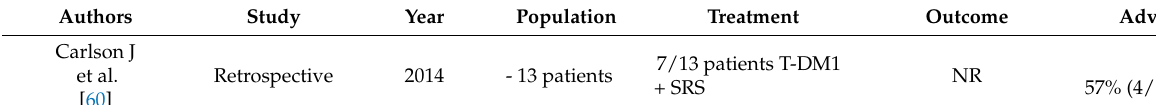
Table 3. Combination of systemic therapy and brain RT: